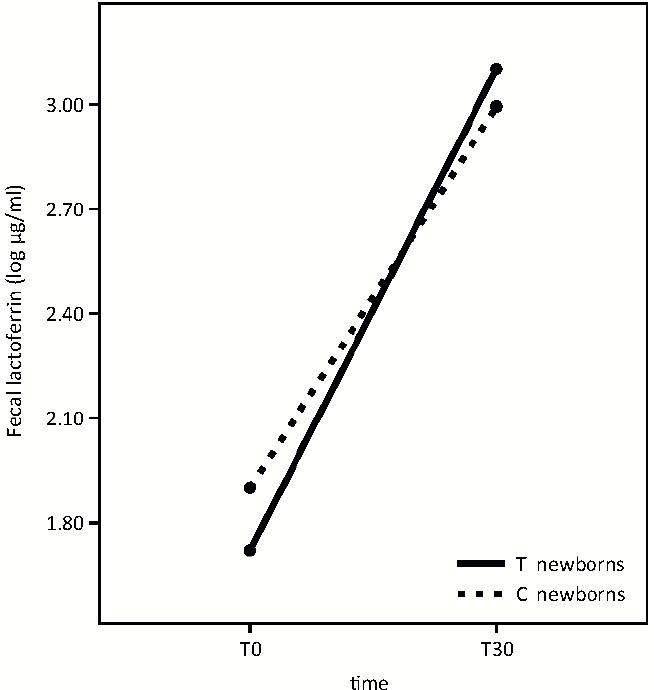
Figure 4. Fecal lactoferrin in treatment (T) and control (C) groups at observational times T0 and T30.